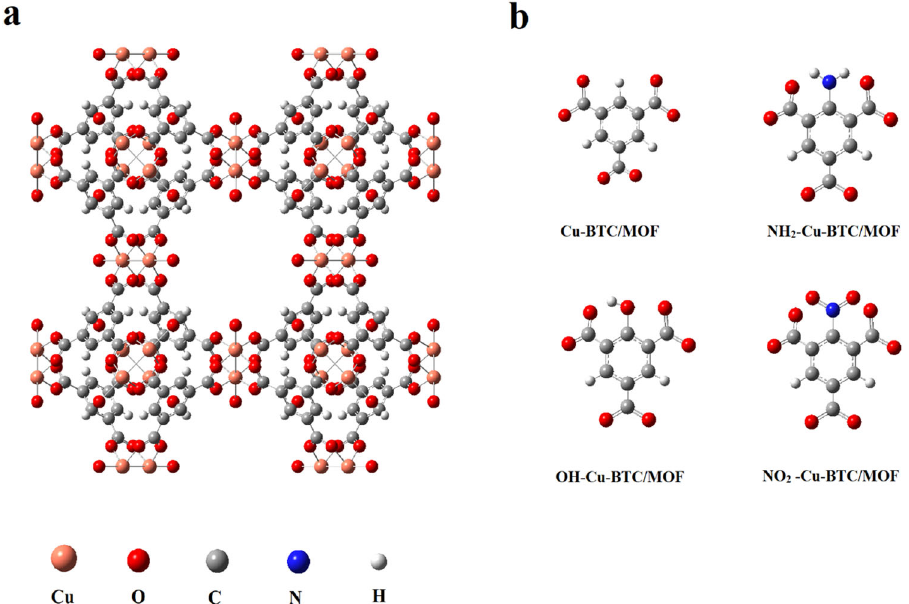
Fig. 9 Structure of a Cu-BTC/MOF and b Functionalized organic linker